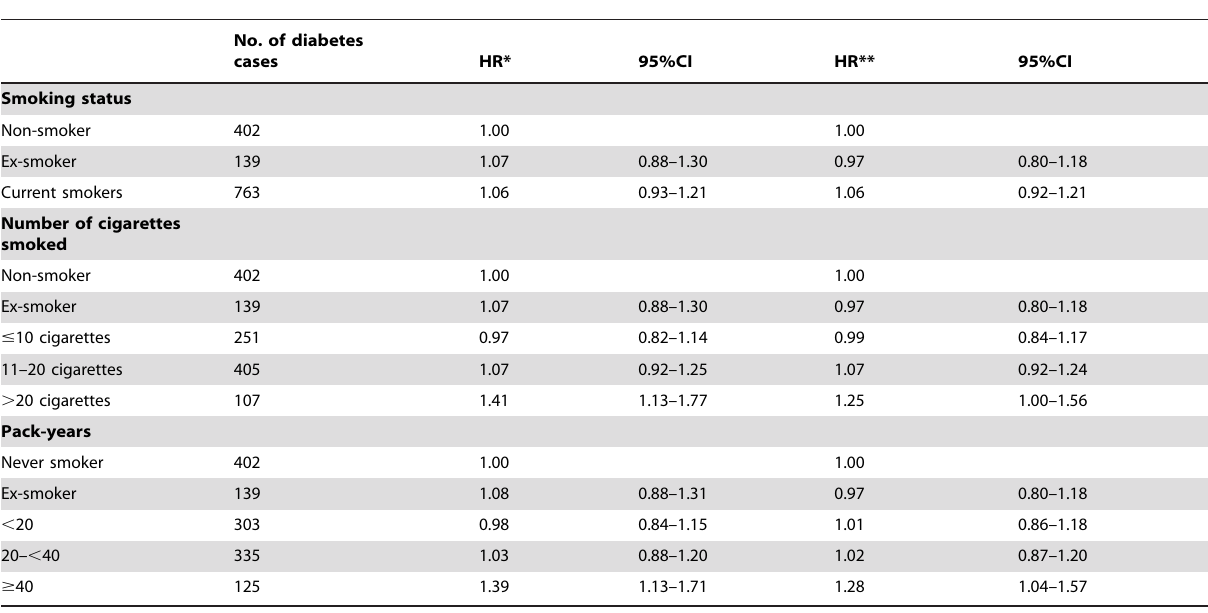
Table 3. Associations between cigarette smoking and T2DM